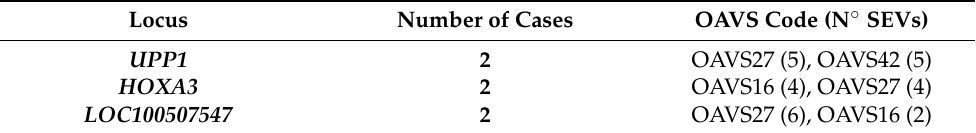
Table 3. Most shared hypo-methylated